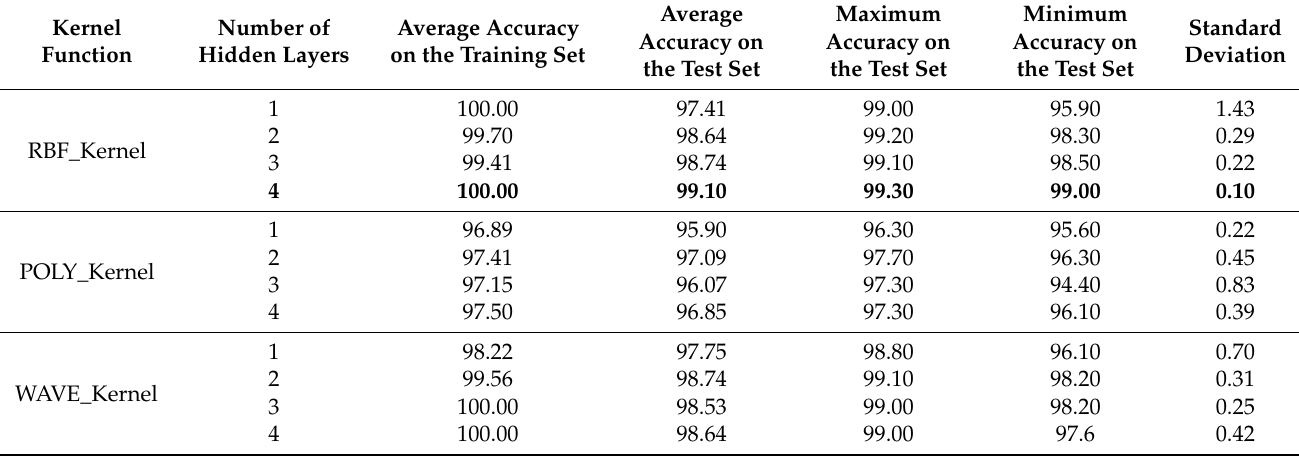
Table 3. Diagnosis performances of ADK-ELM model under different kernel functions (Western Reserve